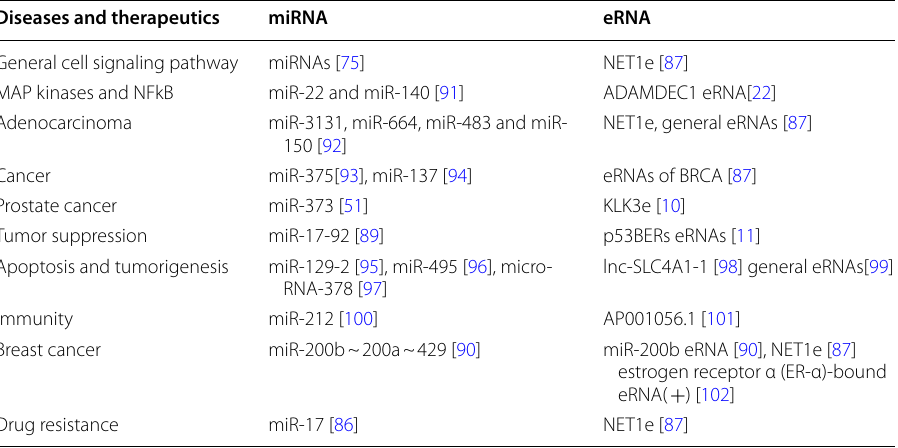
Table 2 Some diseases and therapeutics involving both miRNA and eRNA Diseases and